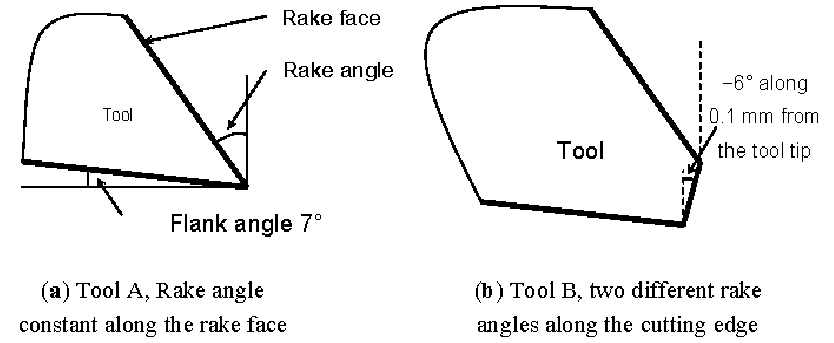
Figure 3. Presentation of the tool geometries used in machining